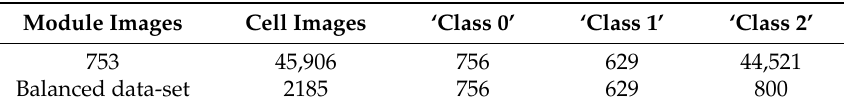
Table 1. Defect classification.